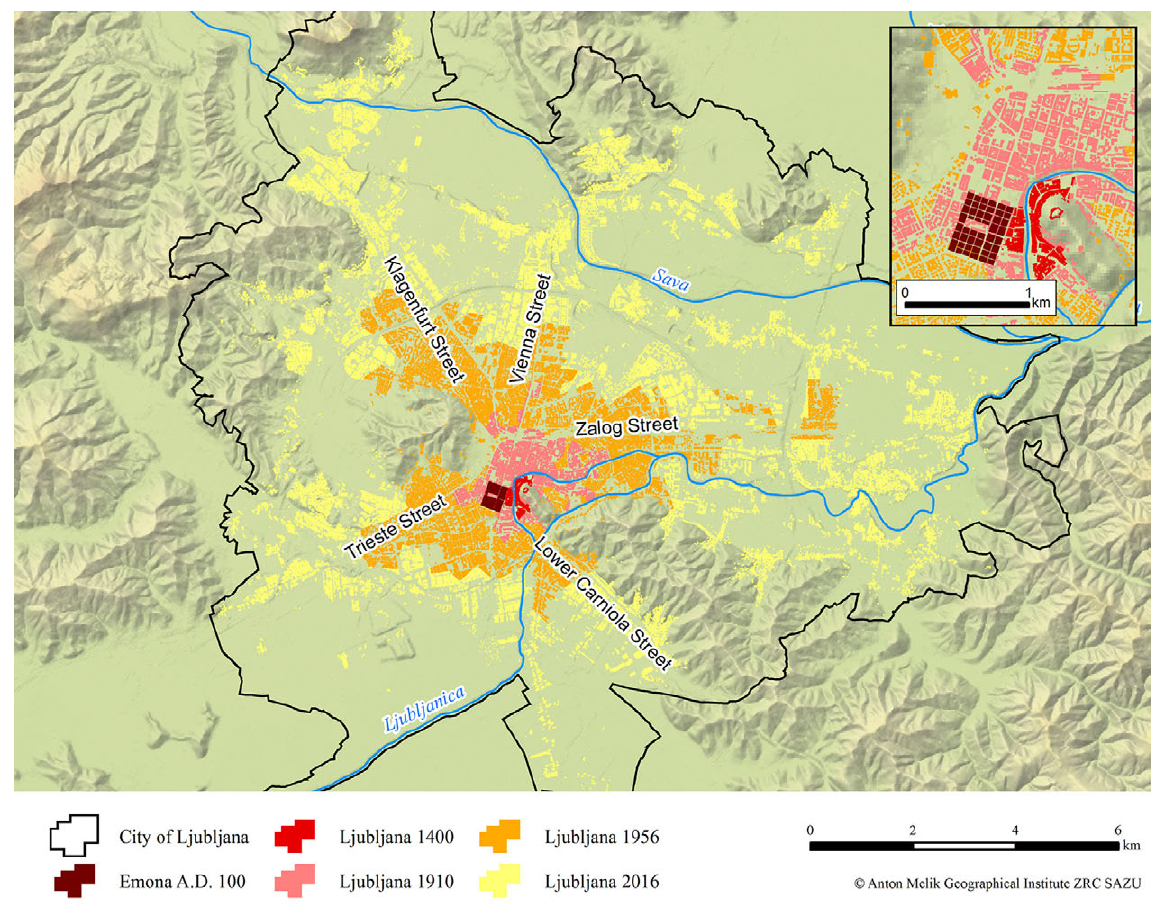
Fig. 3. Spatial growth of the city since the Roman